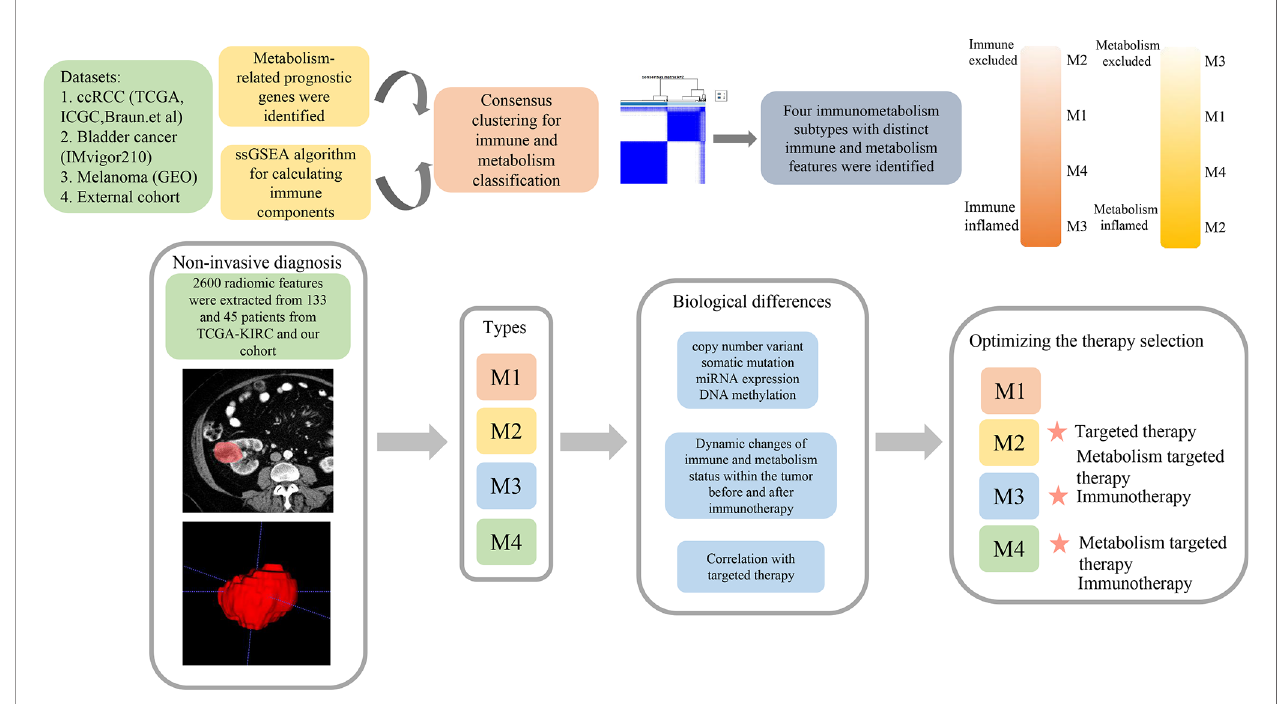
FIGURE 1 | The schematic diagram of the study